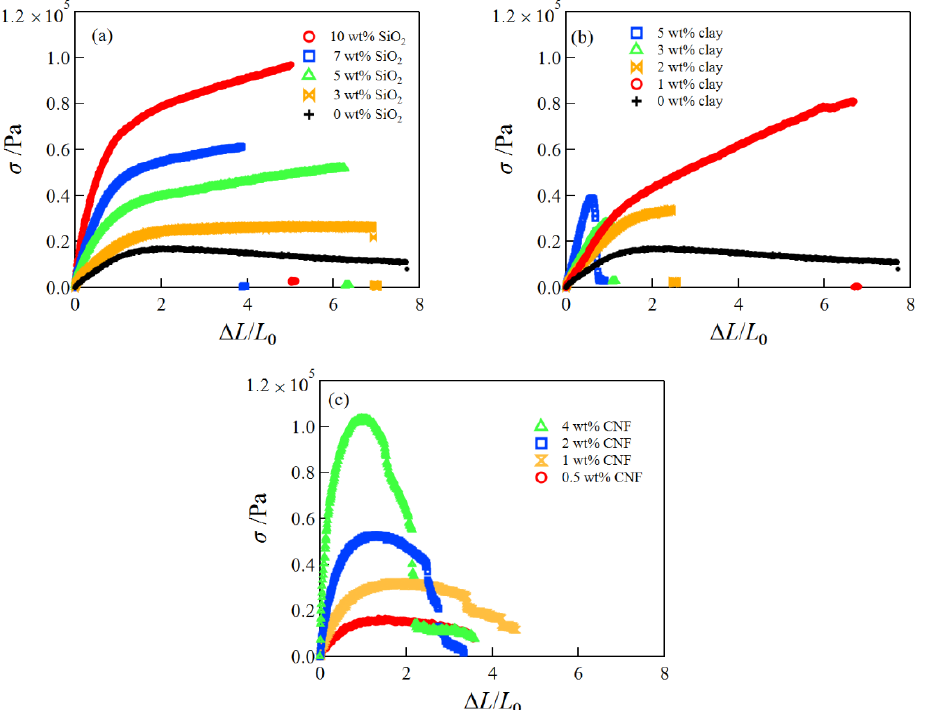
Figure 1. Typical tensile stress–strain curves of SiO 2 /CS/PVA/borax hydrogels at different SiO 2 concentrations ( a ), clay/CS/PVA/borax hydrogels at different clay concentrations ( b ), and CNF/CS/PVA/borax hydrogels at different CNF concentrations ( c ).